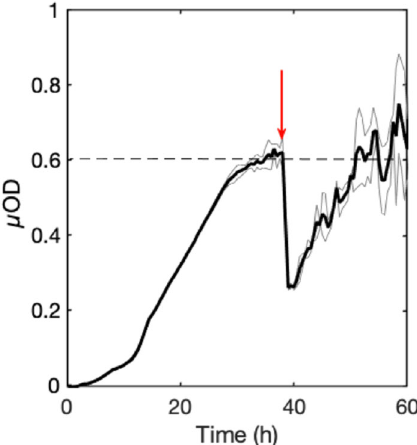
Fig. 2 4S bio fi lm recovery after perturbation. Evolution of the biomass (as reported by µOD) of the 4S bio fi lm grown in the square channel (1 mm 2 ) at 1 mL/h for 38 h at 30 °C, and then partially destroyed by the injection of a 200-µL bubble of air (red arrow). The bold curve shows the average of three distinct positions in the channel (light gray